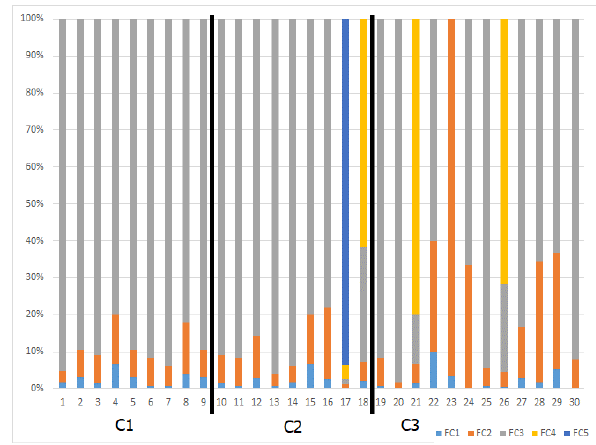
Figure 1: Funding limits in small-scale public contracts.